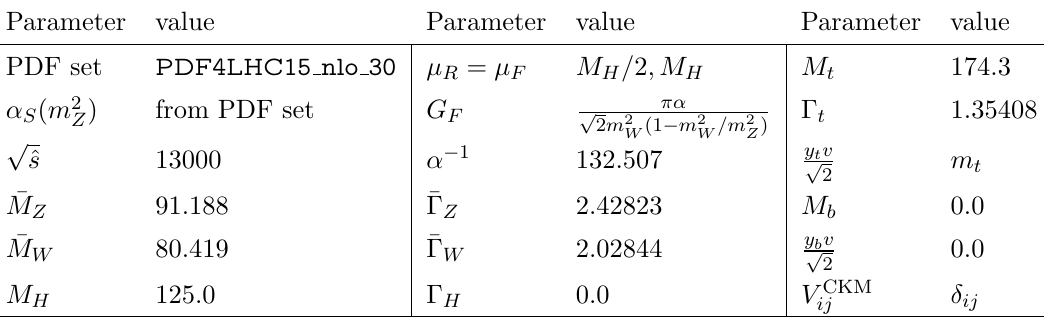
Table 2 . SM parameters used for obtaining all numerical results presented in table 3. Dimensionful parameters are given in GeV. Lower-case mass parameters correspond to their complex-valued counterpart in the complex-mass scheme, i.e. m W = to 13